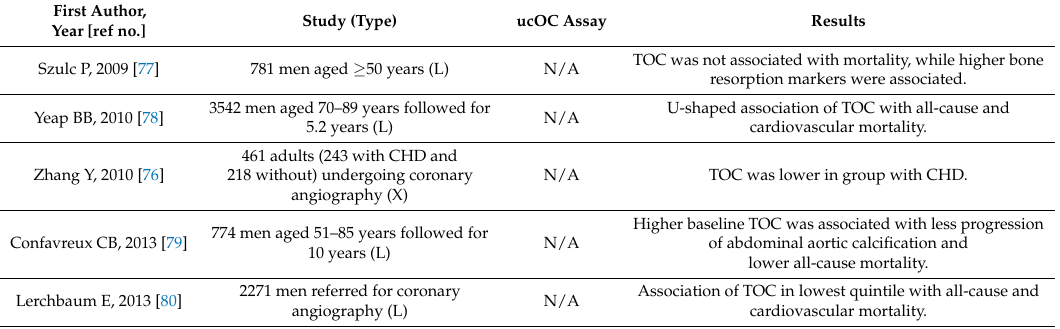
Table 3. Selected studies examining associations of total osteocalcin (TOC) and undercarboxylated osteocalcin (ucOC) with outcomes related to cardiovascular disease and mortality. X = cross-sectional study, L = longitudinal study, CHD = coronary heart disease. * ucOC assayed using hydroxyapatite binding, # ucOC assayed using ucOC antibody, N/A = no ucOC results